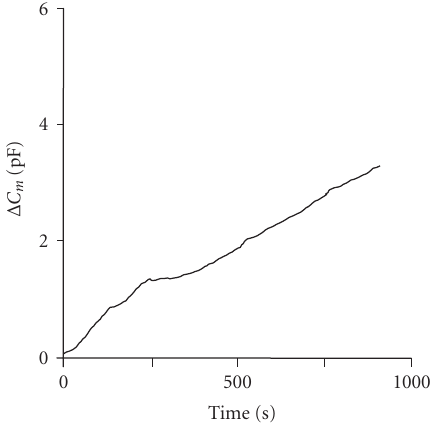
Figure 3: Long exposure to low levels of [Ca 2+ ] i can induce secre- tion of all granules. The change in membrane capacitance induced with a pipette solution containing 10 µ M of [Ca 2+ ] i . The curve is from one of the four recordings that could be followed for more than 15